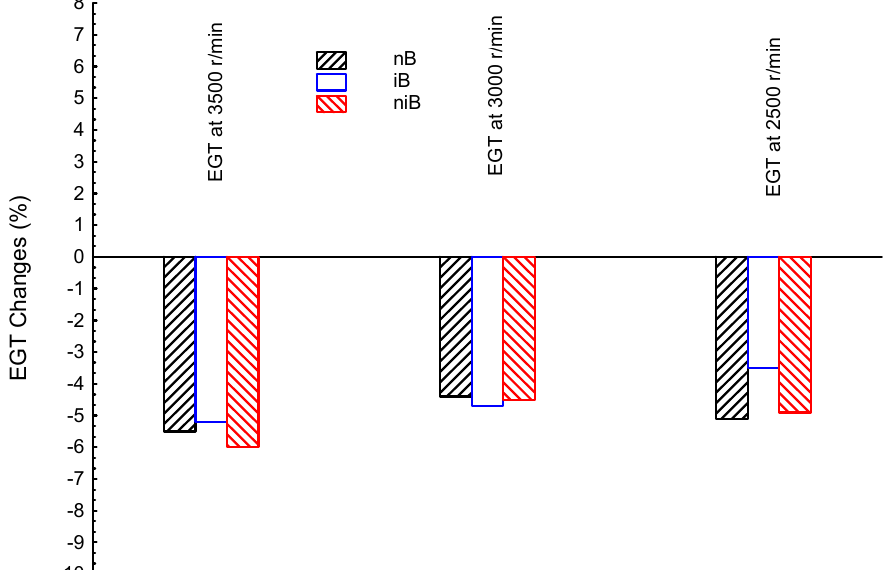
Figure 5. Exhaust gas temperature (EGT) at three different engine speeds (3500, 3000, and 2500 r/min) for blended fuels of n-butanol–iso-butanol–gasoline (niB), iso-butanol–gasoline (iB), and n-butanol–gasoline (nB); gasoline is the reference line.